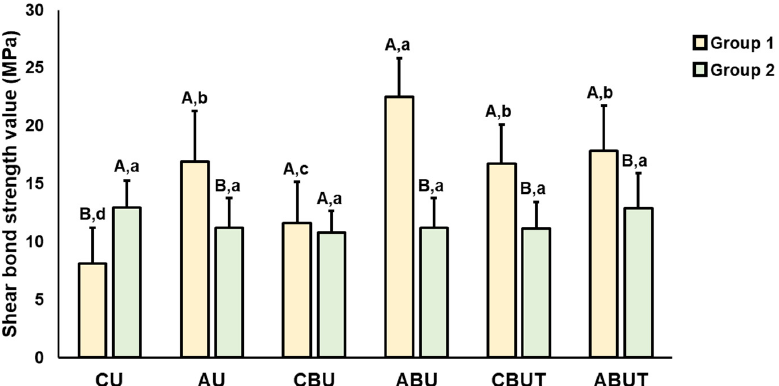
Figure 5. Results of the SBS between Groups 1 and 2 after thermocycling. Uppercase letters indicate significant differences between Groups 1 and 2 within the same adhesion condition, while lowercase letters indicate significant differences between adhesion conditions within each group. Table 3. SBS of both types of 3D printing resins before and after thermocycling.